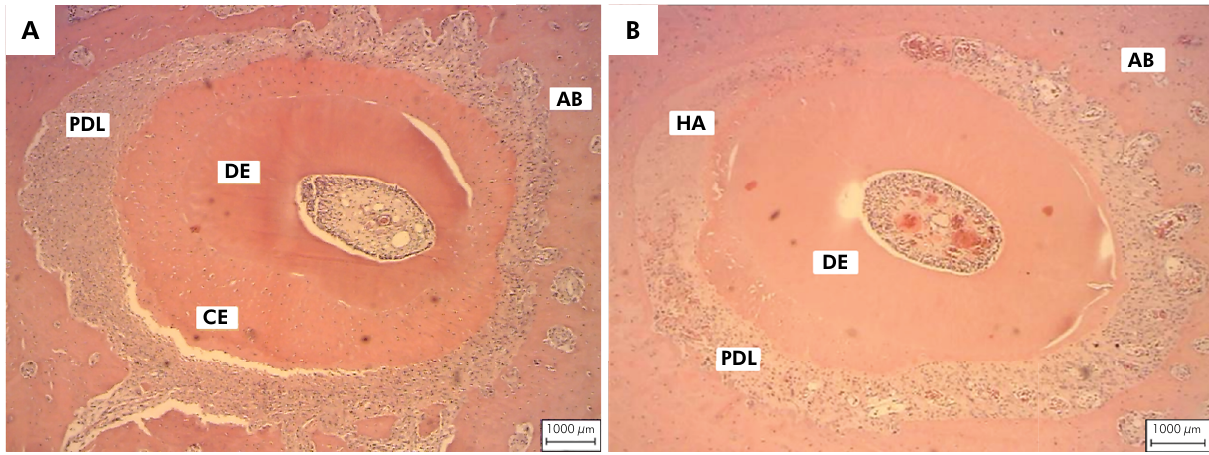
Figure 5. Photomicrographs of the SM (A) and FM (B) groups on the 2 nd